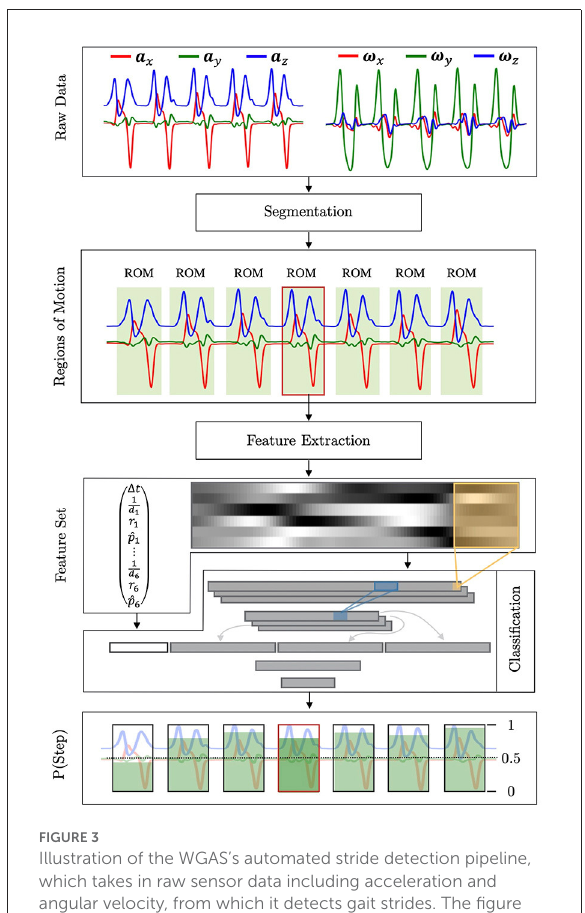
FIGURE3 Illustration of the WGAS’s automated stride detection pipeline, which takes in raw sensor data including acceleration and angular velocity, from which it detects gait strides. The figure outlines each performed operation and shows its respective result. First, the raw data is segmented into multiple ROMs, which constitutes candidate strides. Each ROM is further analyzed individually, by extracting features that are passed to the stepperNet , whose architecture is detailed in Section 2.3.3. Finally, the stepperNet outputs the probability of the input features. If the probability is larger than 0.5, the ROM is accepted as a valid